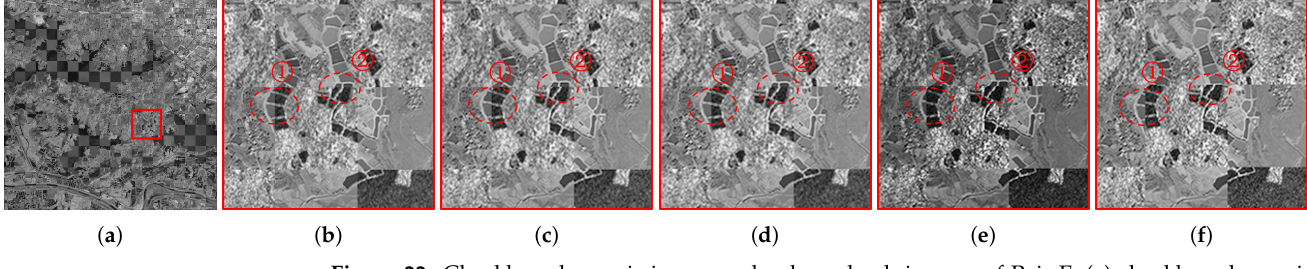
Figure 22. Checkboard mosaic image and enlarged sub-images of Pair E: ( a ) checkboard mosaic image of HOPES; ( b – f ) enlarged sub-images of HOPES, CFOG, HOPC, SAR-SIFT,